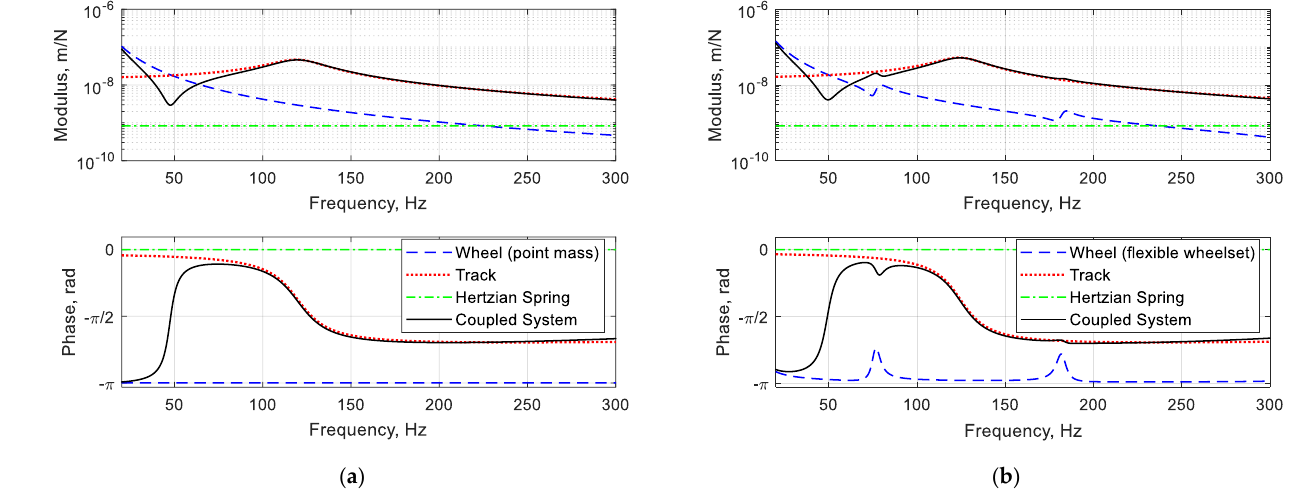
Figure 8. Wheel, track, Hertzian spring and coupled wheel–rail system direct vertical receptances: ( a ) considering the wheelset as a point mass; ( b ) considering the deformable wheelset model. The equations written above are valid for both point mass and flexible wheelset models. They differ only in the analytical expression of 𝐴 𝑊𝑧 (𝑓). The main difference between